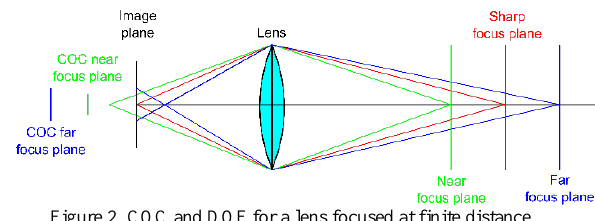
Figure 2. COC and DOF for a lens focused at finite